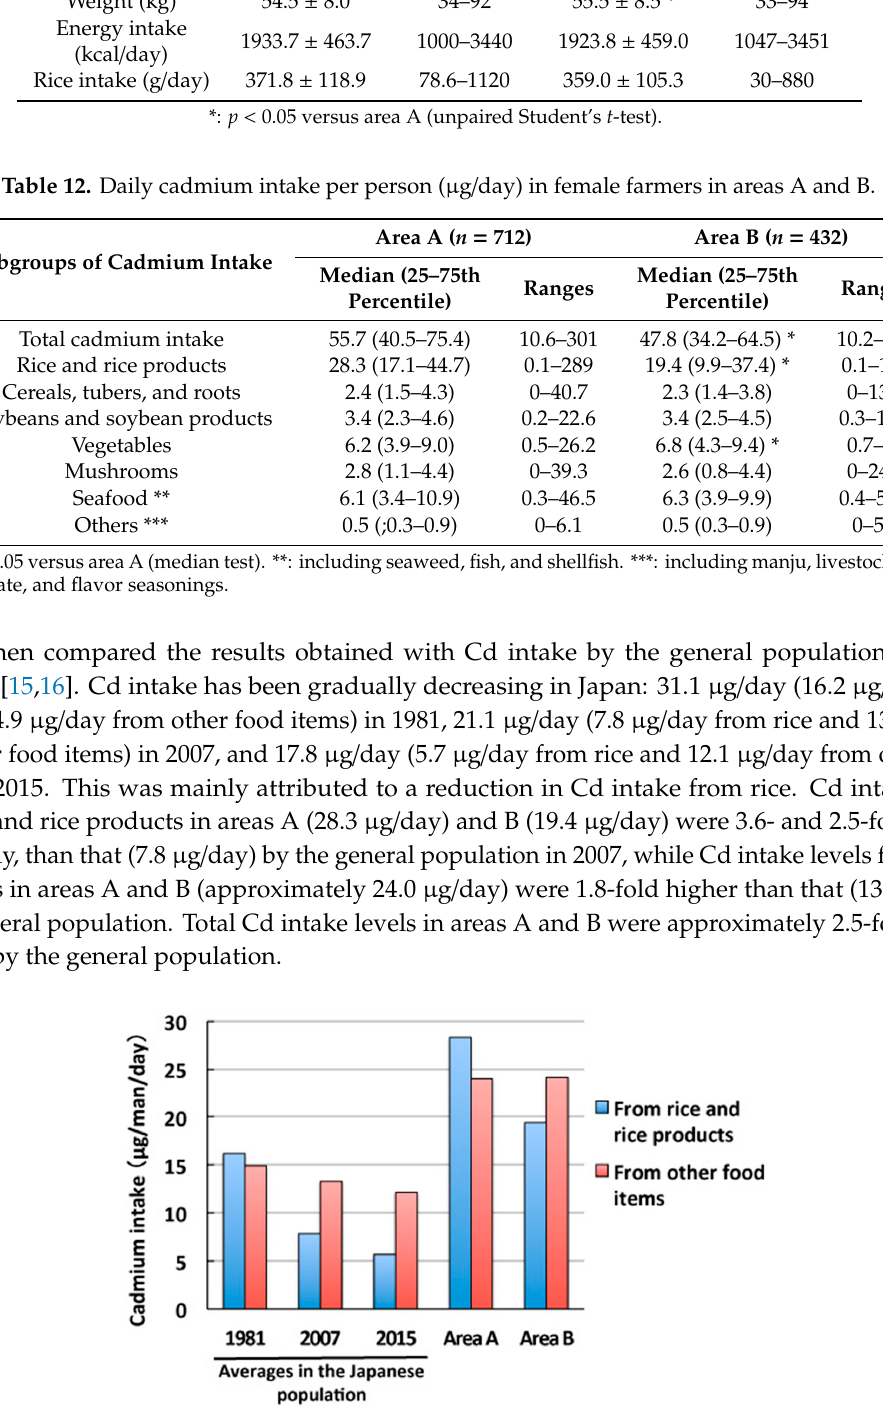
Figure 2. Cadmium intake levels per person from rice and rice products and from others in female farmers in cadmium-polluted areas A and B in Akita, Japan, shown by medians, and comparisons with average cadmium intake in the Japanese population.